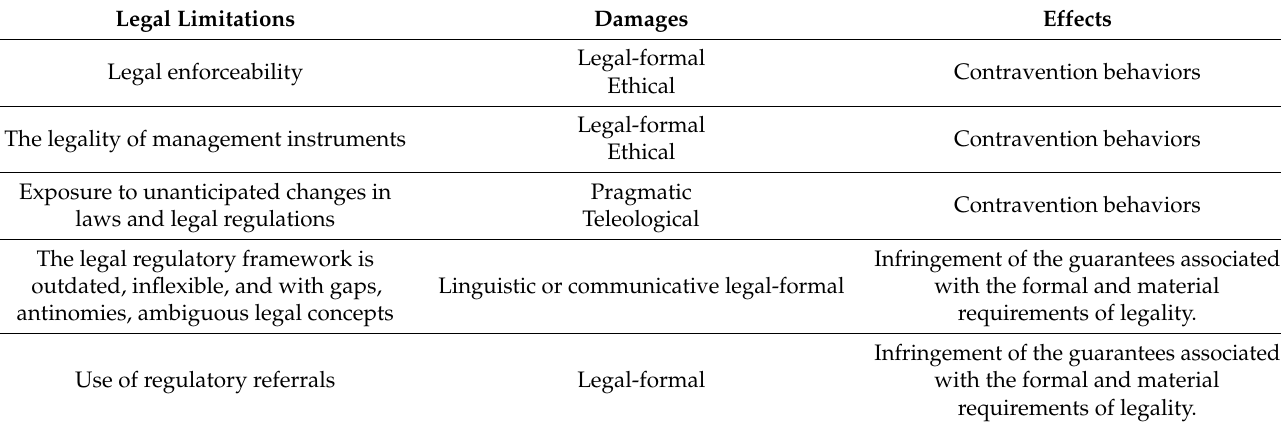
Table 5. Relationships between legal limitations according to damage and